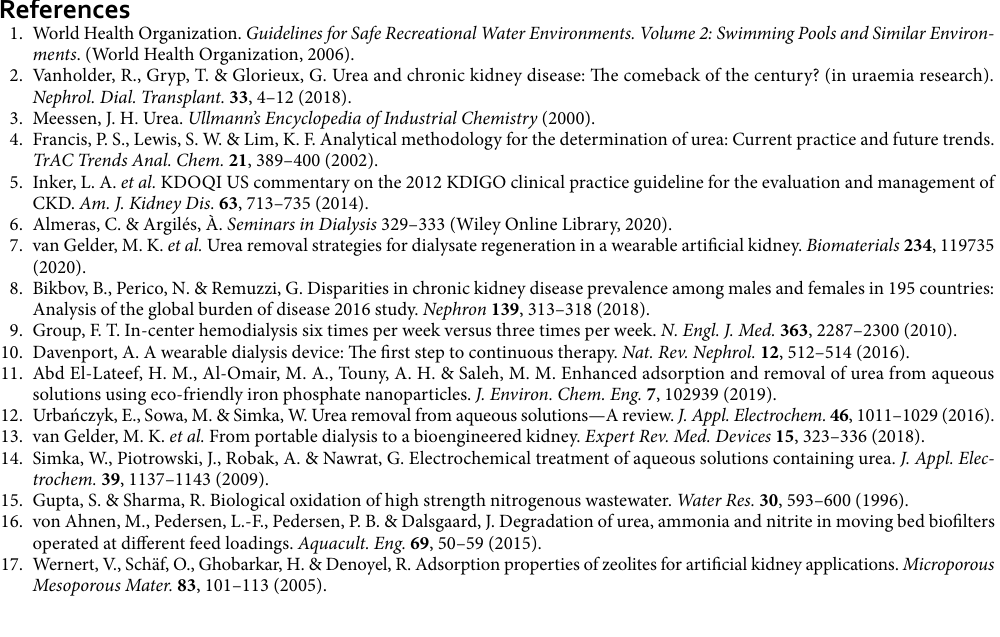
Fig. S4. (Fig. 3 of the supplementary) Each MD simulation performed in a 6 nm length cubic box and a periodic boundary condition applied in all direction. It should be noted that in each simulation the box consists of one COF NS, 20 urea molecules, and 6500 water